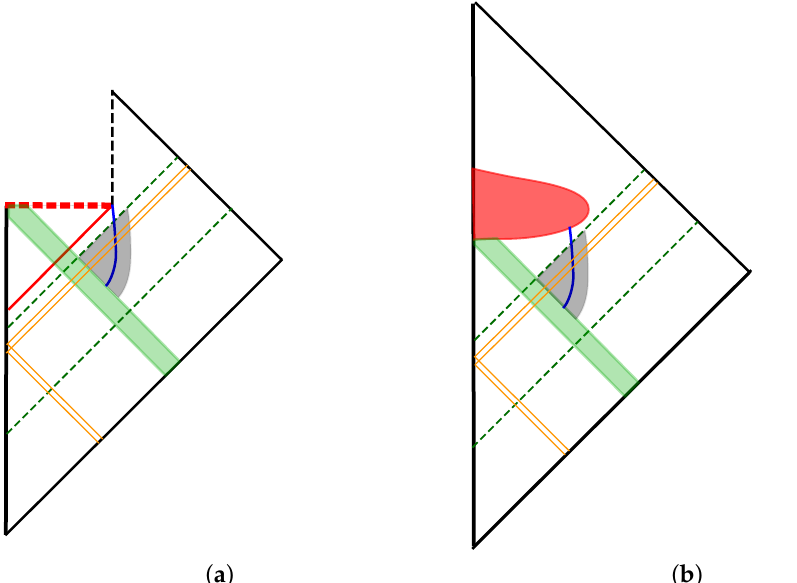
Figure 1. ( a ) is the Penrose diagram of the conventional model of black holes. The diagonal red line represents the event horizon. ( b ) is the Penrose diagram for the dynamical black hole assuming that the singularity at r = 0 is replaced by a region (the red blob) of Planckian curvature. In both Penrose diagrams, the curved green stripe represents the collapsing matter, which is assumed to be falling at the speed of light for simplicity. The blue curve represents the apparent horizon outside the matter, and the gray shade the near-horizon region.